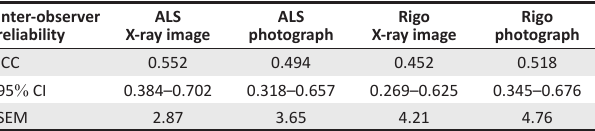
TABLE 1 : Inter-observer reliability analysis for augmented Lehnert-Schroth classification and Rigo classifications.